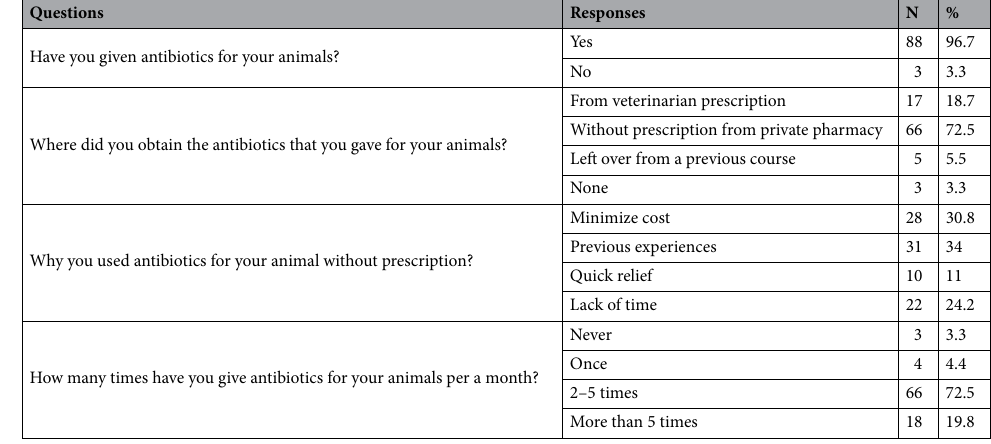
Table 2. Antibiotic use for animals in north western Ethiopia by animal farm owners/workers (N = 91).